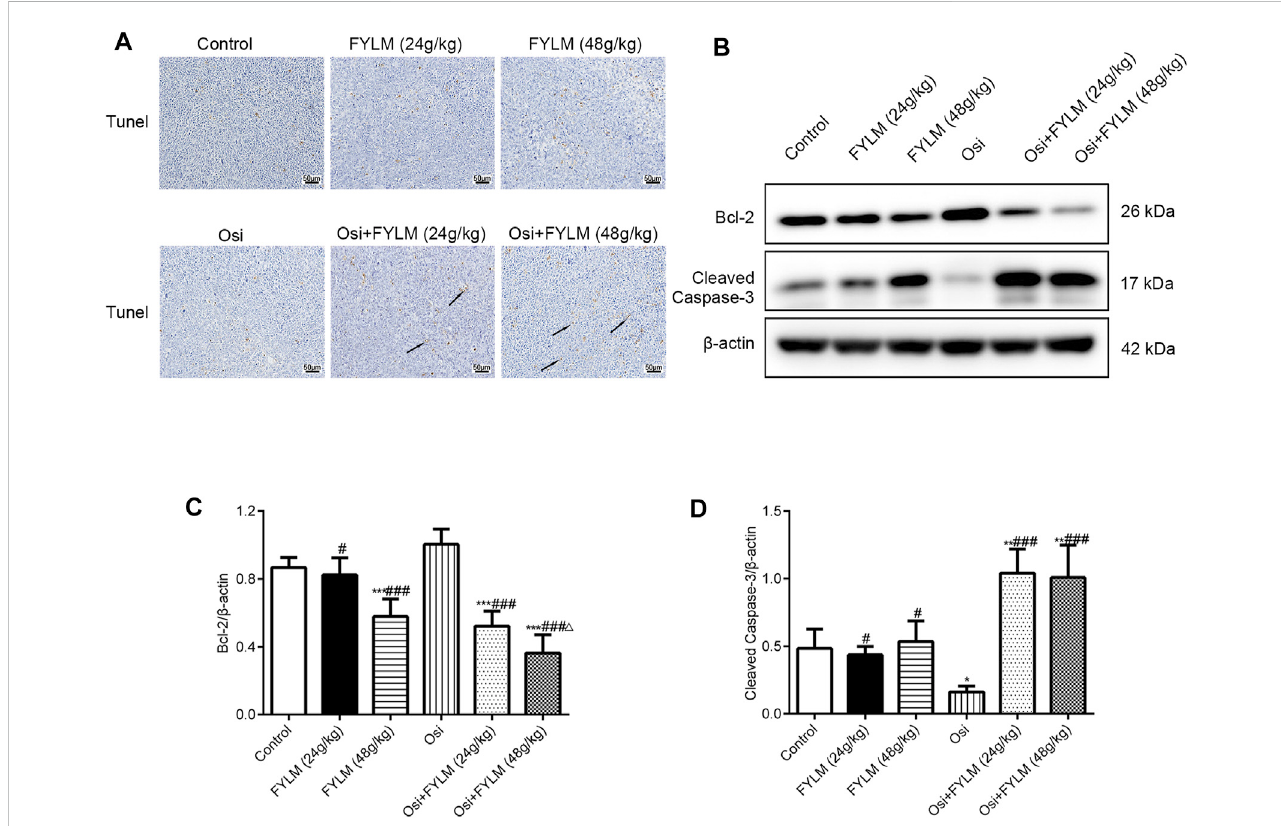
FIGURE 6 FYLMcombinedwithosimertinibregulatesapoptosisinEGFR-Del19/T790M/C797SLLCtumor-bearingmice. (A) Detectionofapoptosisintumortissues by TUNEL staining. Arrows indicate brown-yellow apoptotic cells. (B) Bcl-2 and cleaved Caspase-3 proteins were detected by western blotting. (C,D) Quantitativeanalysis ofBcl-2 and cleaved Caspase-3 proteinlevels.* p < 0.05, ** p < 0.01 and*** p < 0.001 vs.Control; # p < 0.05and ### p < 0.001 vs.Osi; △ p < 0.05 vs. Osi + FYLM (24 g/kg). Osi, osimertinib. All data are shown as mean ±